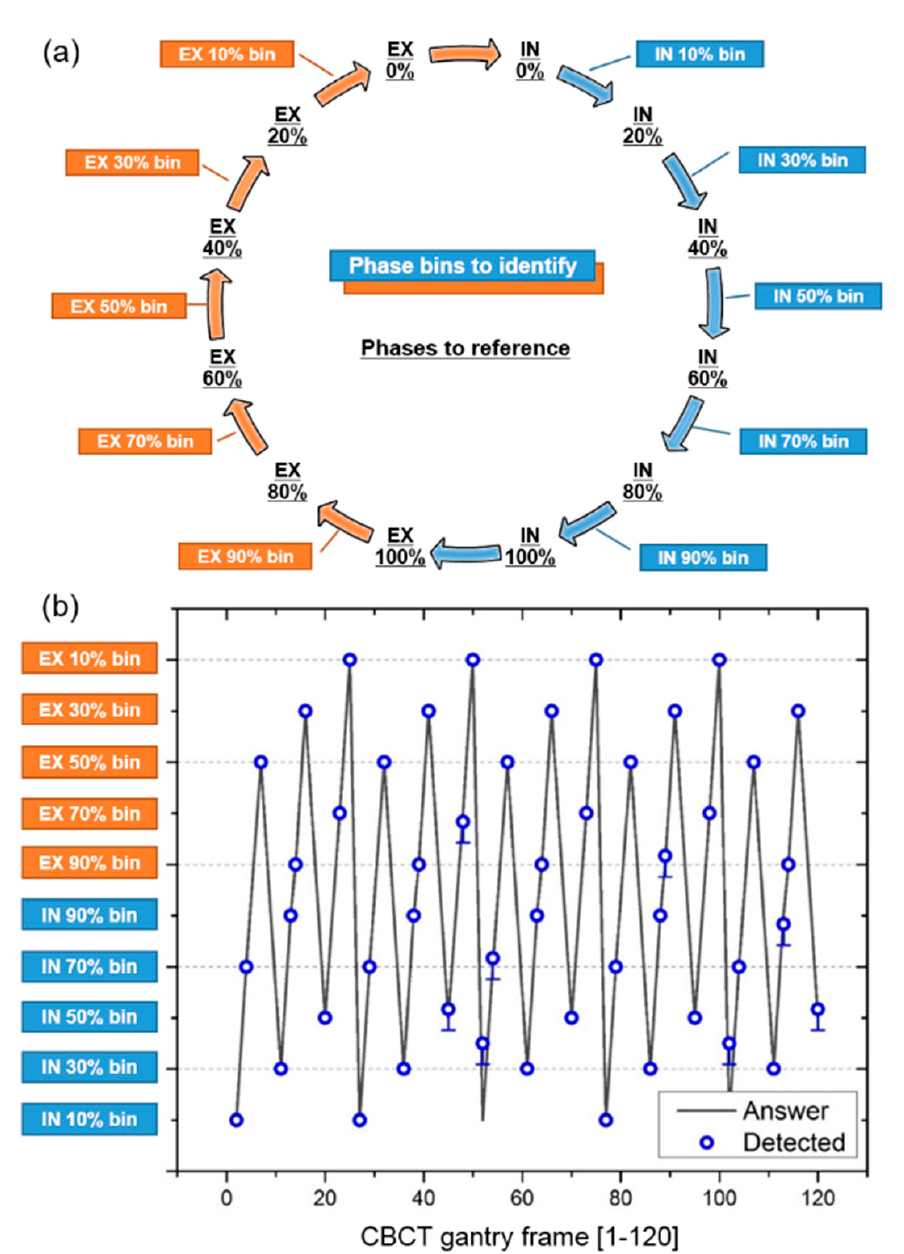
Figure 3. ( a ) Selection of respiratory phase bins to identify (boxed), and respiratory phases to reference (underlined), from the planning 4DCT images for each 10% of the respiratory phase. ( b ) The respiratory phase bins to identify were assigned as a function of the gantry frame. The correct phase of the projection images of the missing phases (phase bins to identify) were detected using the existing respiratory phase data (phases to reference). The correct and detected phases achieved using the proposed method are labeled “Answer” and “Detected,”